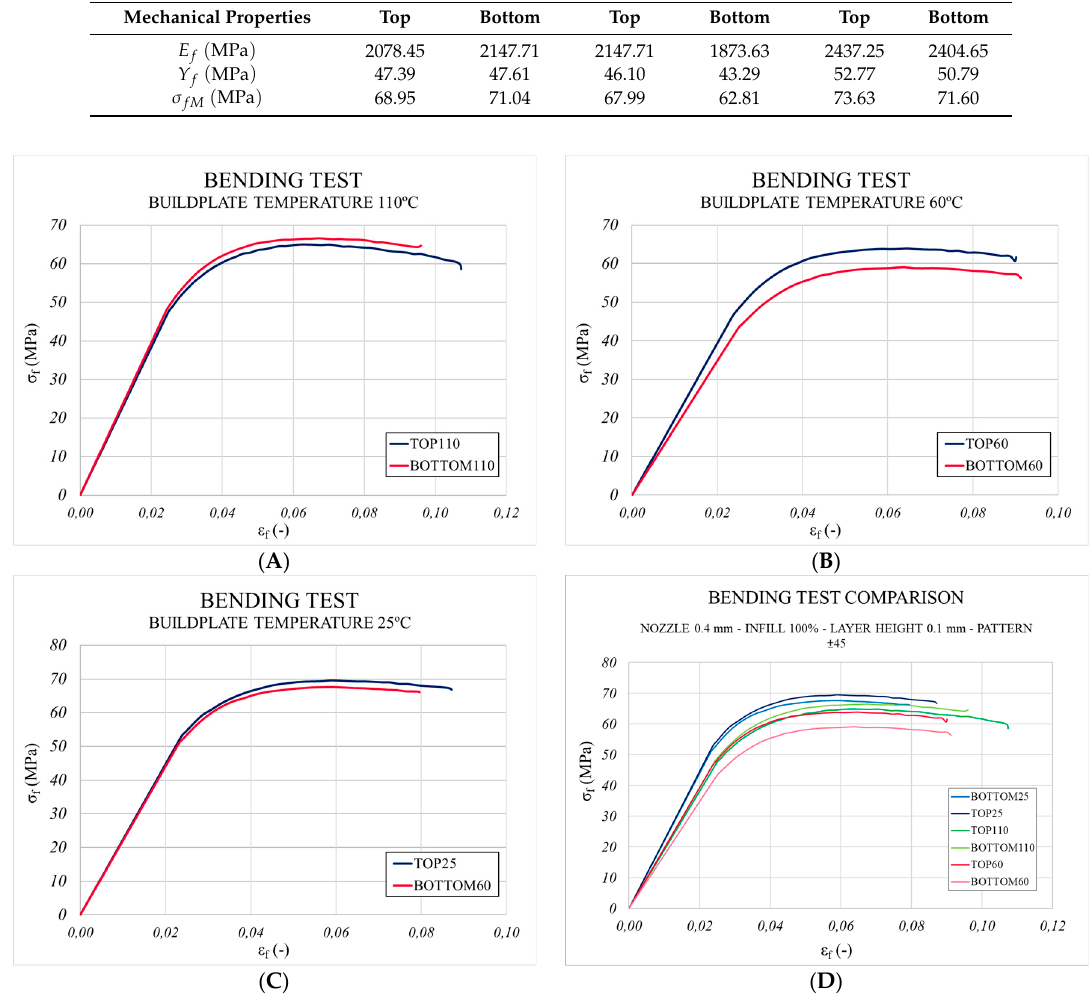
Figure 5. Analysis of the mechanical response of the samples manufactured by 3D printing at different build plate temperatures to study if anisotropy was caused by the thermal environment. ( A ) Build plate temperature: 110 °C, ( B ) build plate temperature: 60 °C, ( C ) build plate temperature: 25 °C and ( D ) bending test comparison of ( A – C ). Table 1. Mechanical properties obtained from the bending tests.